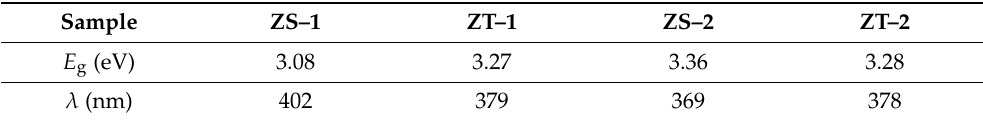
Figure 5. UV–Vis diffuse-reflectance and PL excitation spectroscopy of ZT–2 ( a ), Kubelka–Munk estimation of the optical band gap of ZT–2 ( b ), and PL emission spectra of ZT–2 ( c ). Table 4. Estimated optical band gap energy values of ZS–1, ZT–1, ZS–2, and ZT–2 catalysts and their corresponding absorption